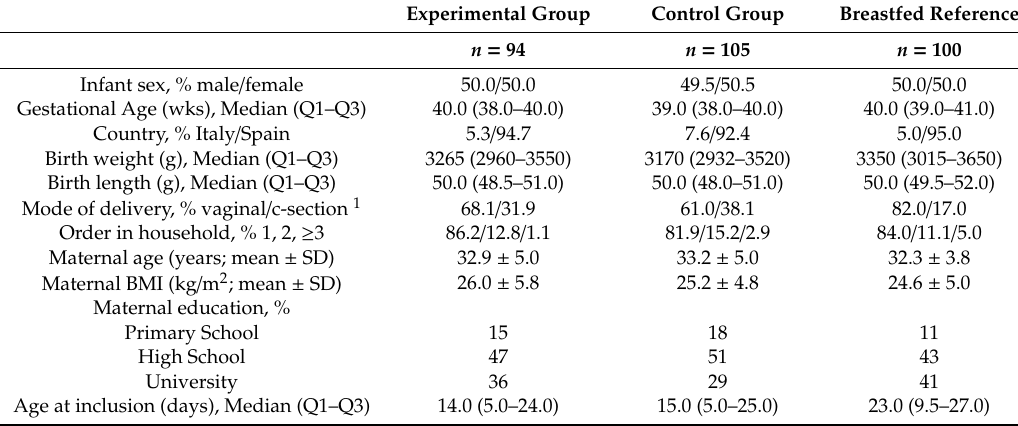
1 Data missing for one infant in the control group. * No statistical significant di ff erences (P < 0.05) in characteristics were observed between both intervention